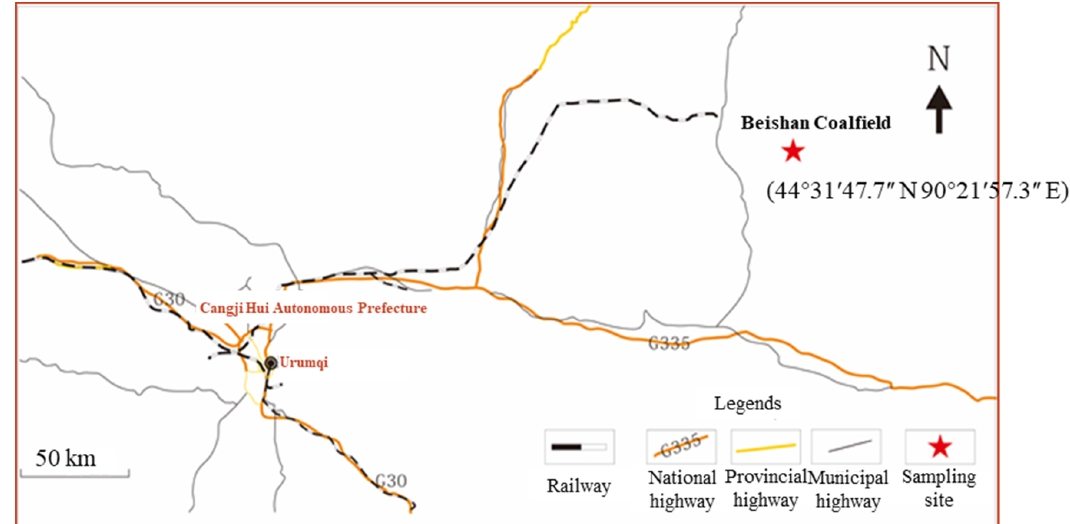
Figure 1. A location map of the Beishan Coalfield and the sampling site (Adapted from Zeng et al.,